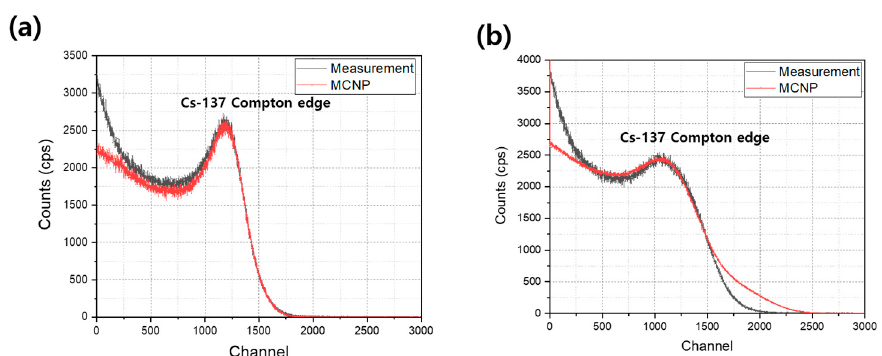
Figure 9. Normalized results from measured and simulated energy spectrum of commercial and CdTe-loaded plastic scintillator to Cs-137 gamma ray source. ( a ) Point source measurement using commercial plastic scintillator. ( b ) Point source measurement using a functional plastic scintillator including CdTe.